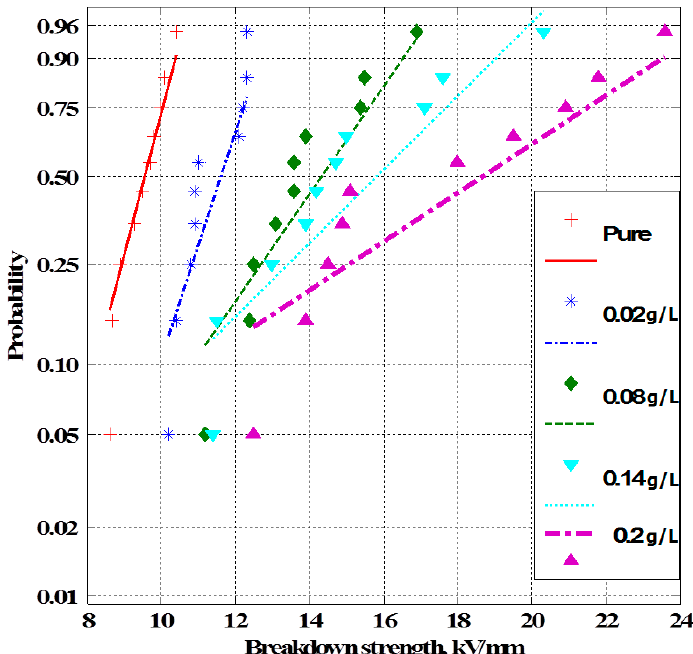
Figure 6. Weibull probability curves for breakdown strength of TiO 2 /nanofilled transformer oil.